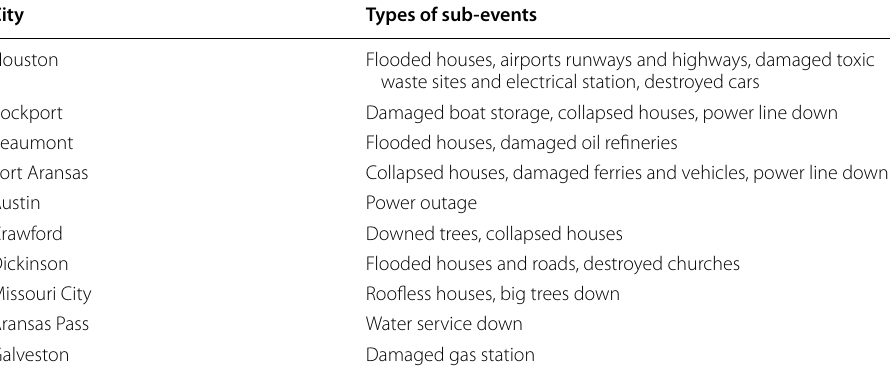
Table 6 Main sub-events detected in tweets about